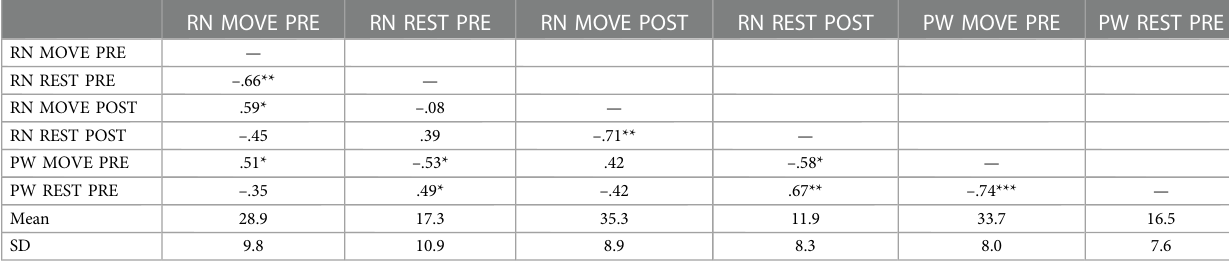
TABLE 1 Correlation Matrix (Pearson ’ s r ) and descriptive statistics for “ Past week ” (PW) and “ Right now ” (RN) versions of the CRAVE Scale, measuring desires and wants to move and rest. RN MOVE PRE RN REST PRE RN MOVE POST RN REST